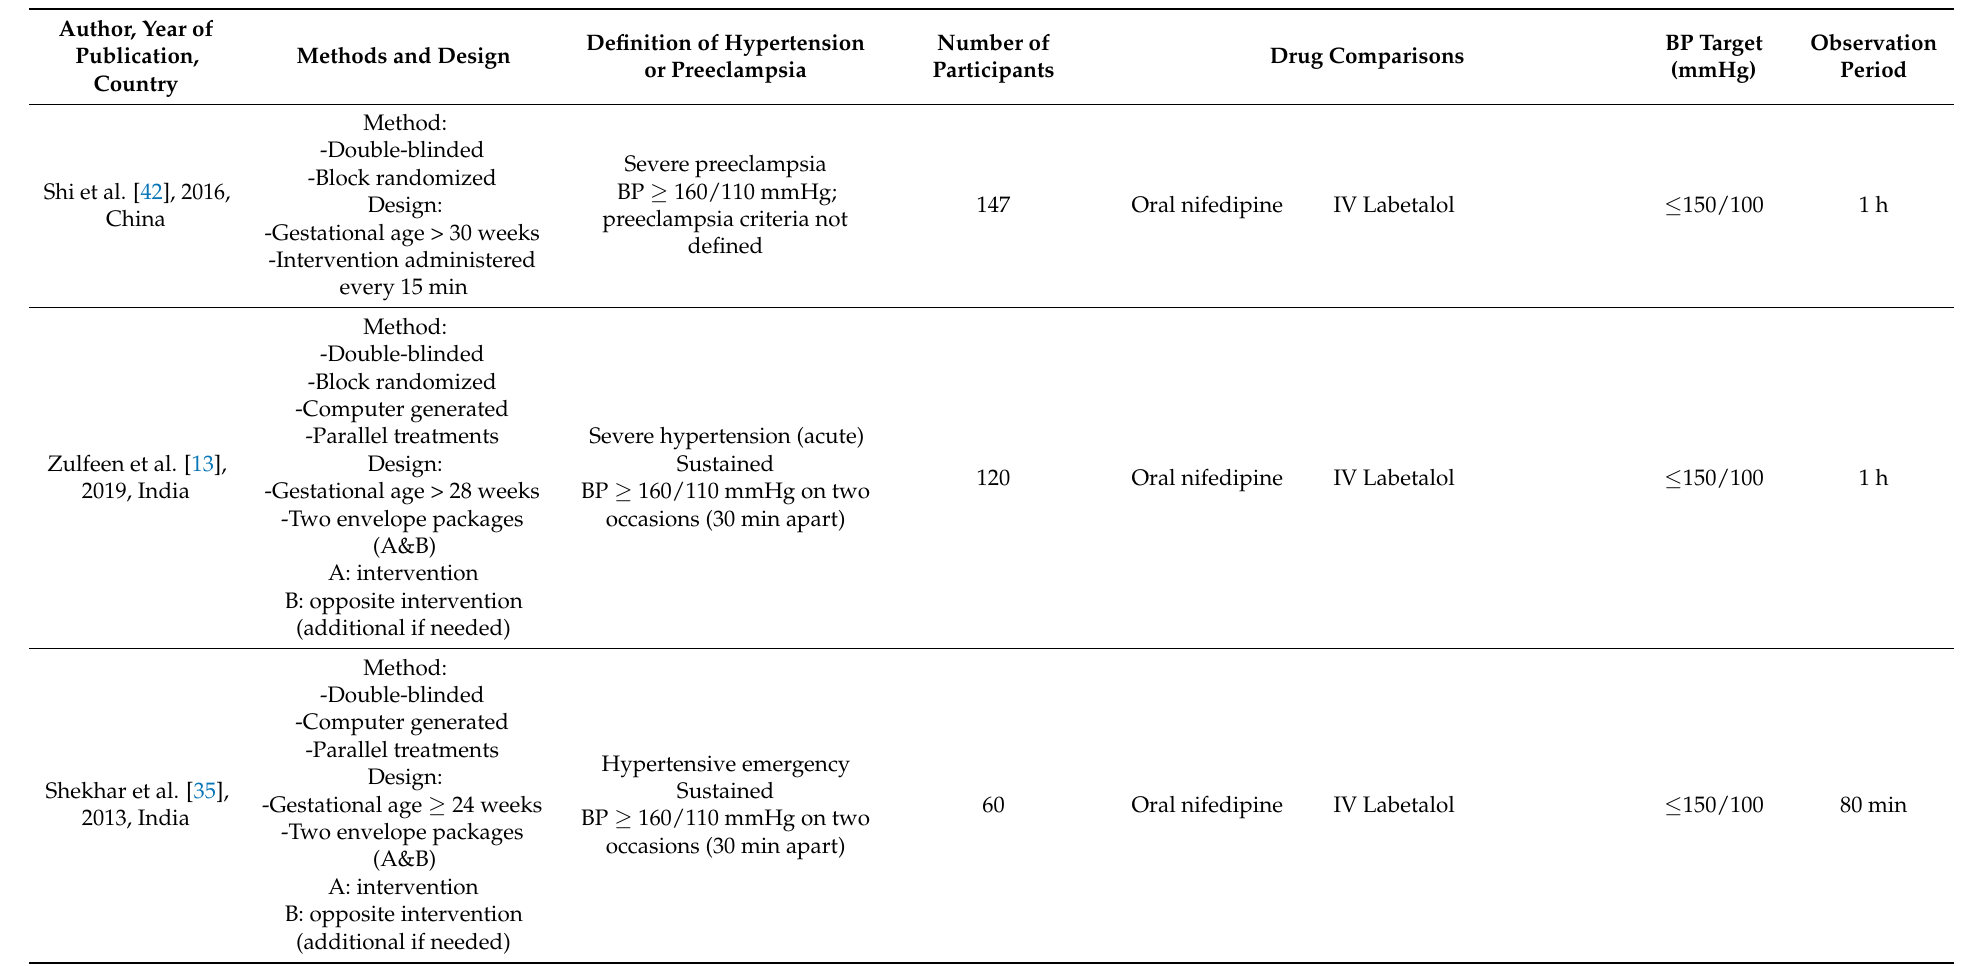
Table 3. Characteristics of studies